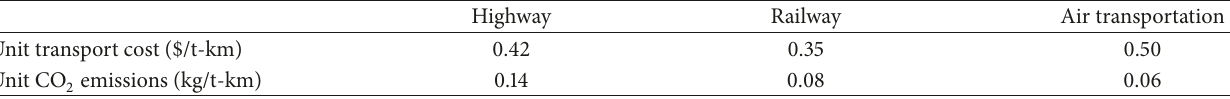
Table 1: Unit transport cost and CO 2 emissions.